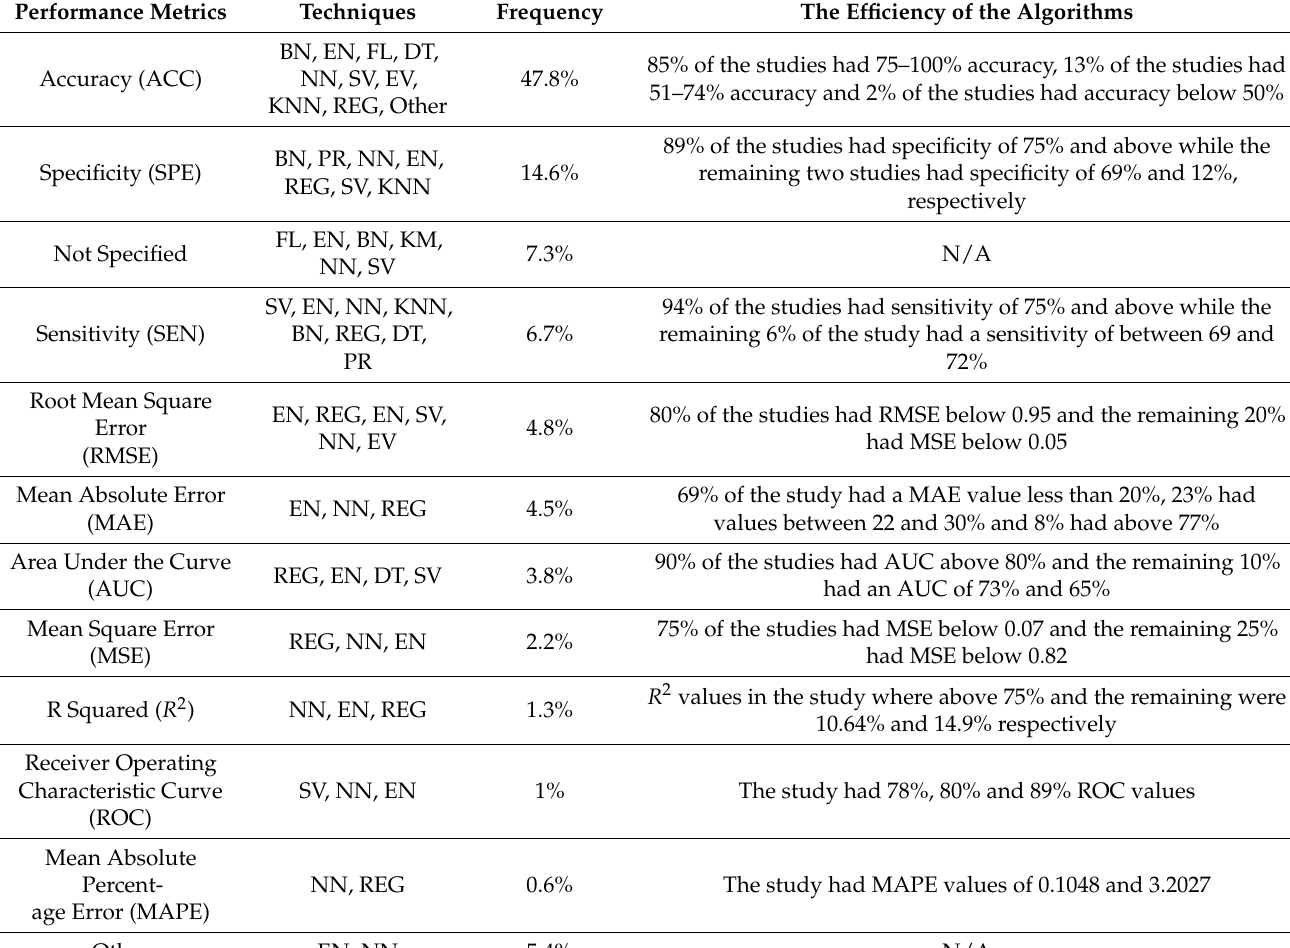
Table 9. Efficiency of the